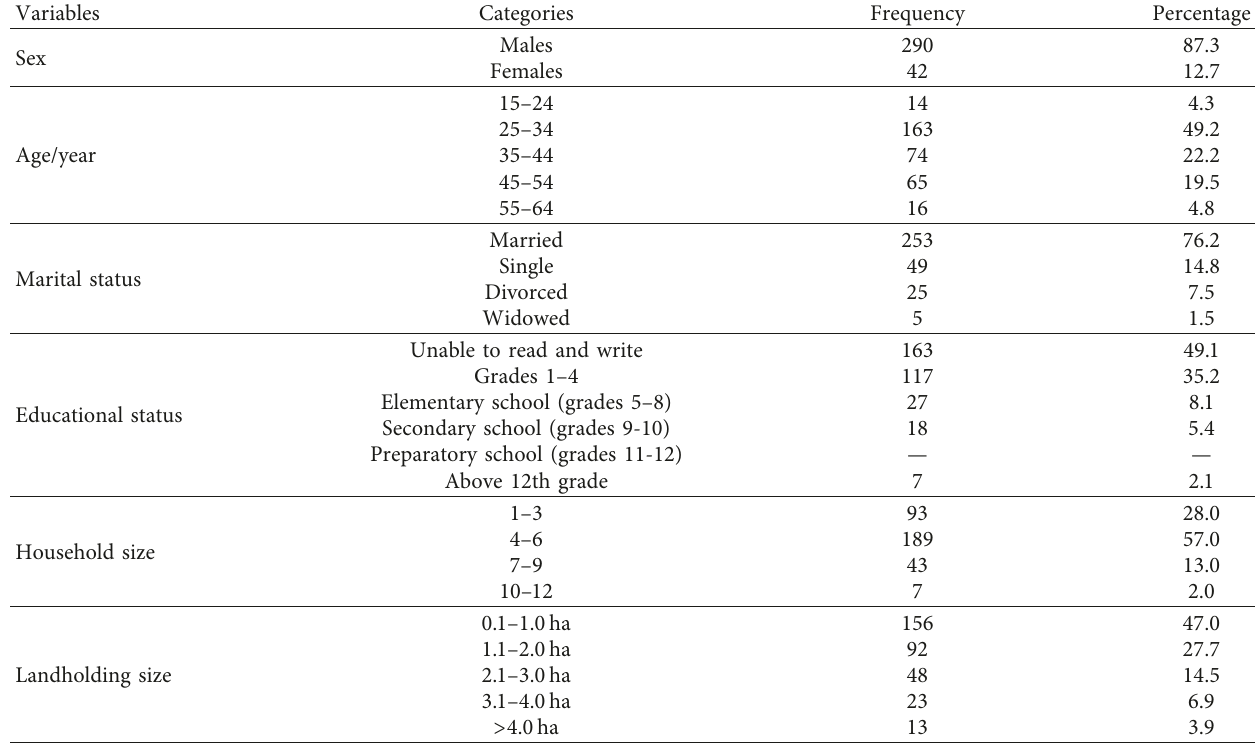
Table 2: Social and economic data on the